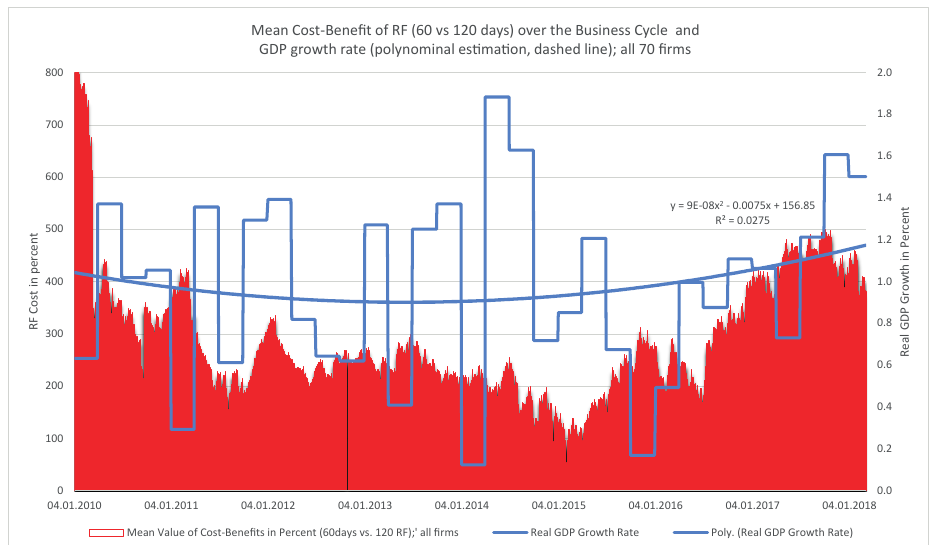
Figure A2. Reverse factoring over the business cycle. Source: Authors’ simulation and